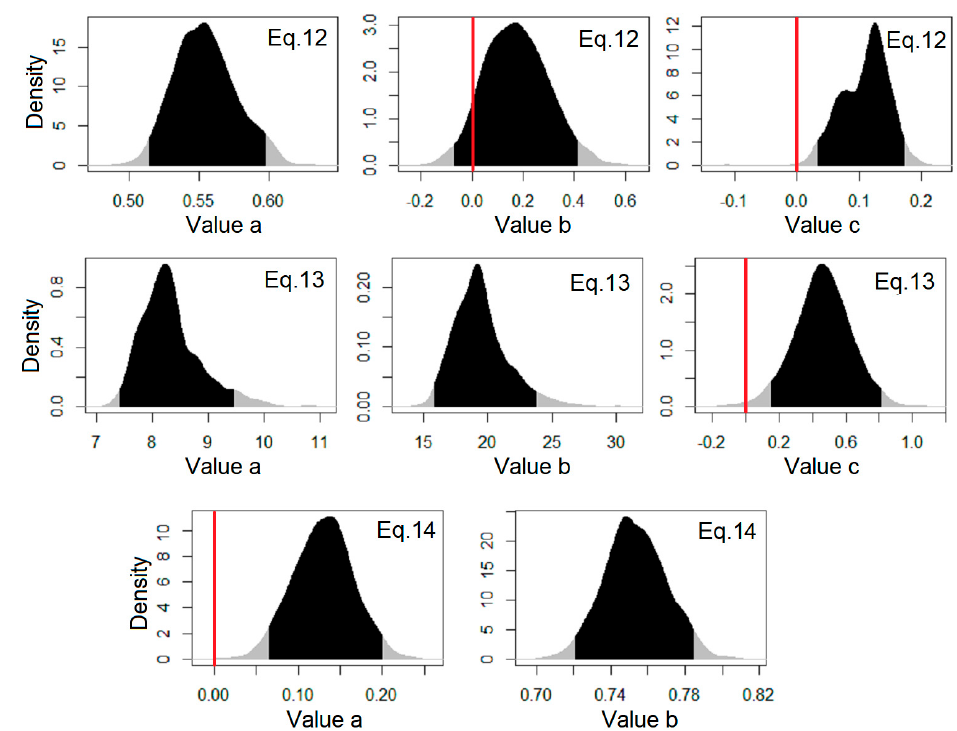
Figure 1. High posterior density (HPD) distributions of the 1000 values of each regression coefficient of Equations (9)–(14) during the random cross-validation nonlinear regression (RCV-NLR) calibration procedure (when the red line is in the black area, the coefficient and the respective model is not robust).